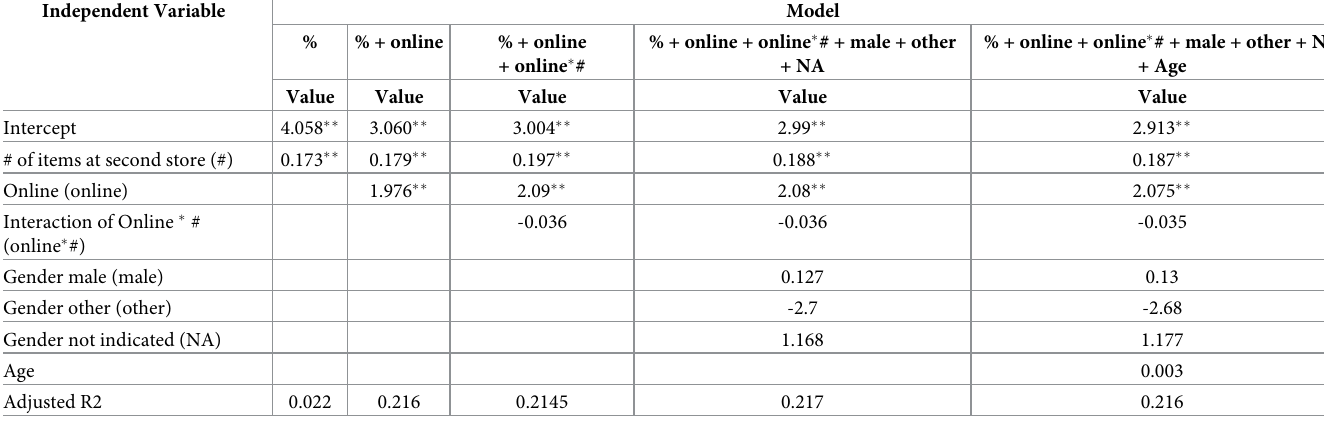
Table 15. Linear Regression results against likelihood (n = 464) (Study